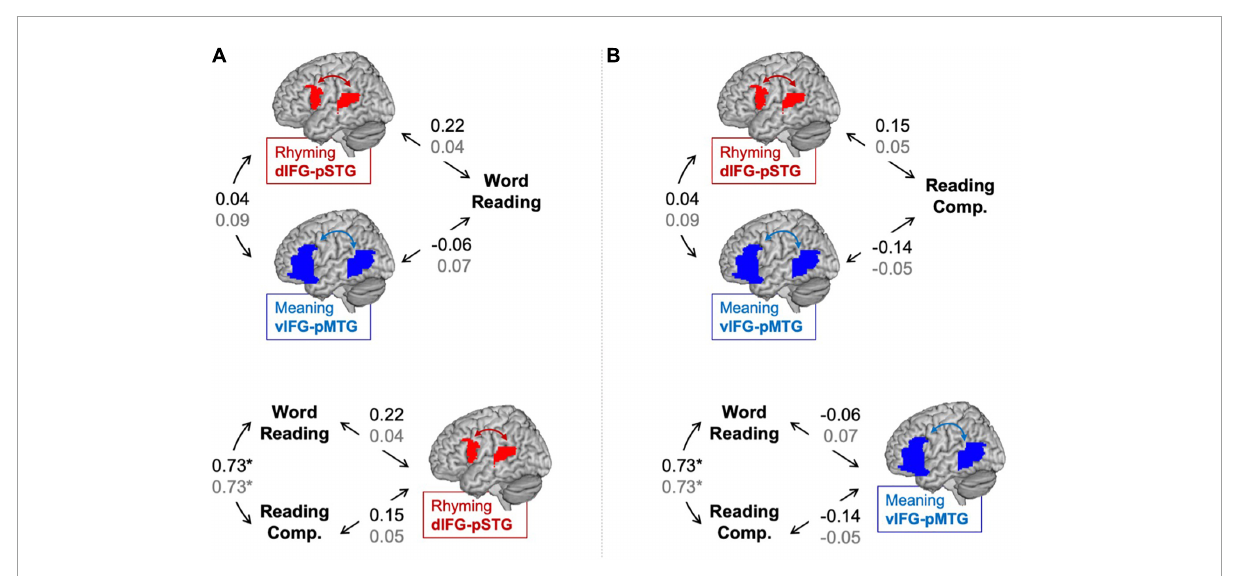
FIGURE1 Partial correlations (controlling for age) between connectivity and reading assessments in the lexical > fixation (black) and the target-conditions > fixation (gray) contrasts. Panel (A) tests the hypotheses that the dorsal pathway for phonology is associated with word reading skill more than the ventral pathway for semantics and that word reading skill is associated with the dorsal pathway for phonology more than reading comprehension skill. Panel (B) tests the hypotheses that the ventral pathway for semantics is associated with reading comprehension skill more than the dorsal pathway for phonology and that reading comprehension skill is associated with the ventral pathway for semantics more than word reading skill. Statistically significant correlation denoted by an asterisk. * p <